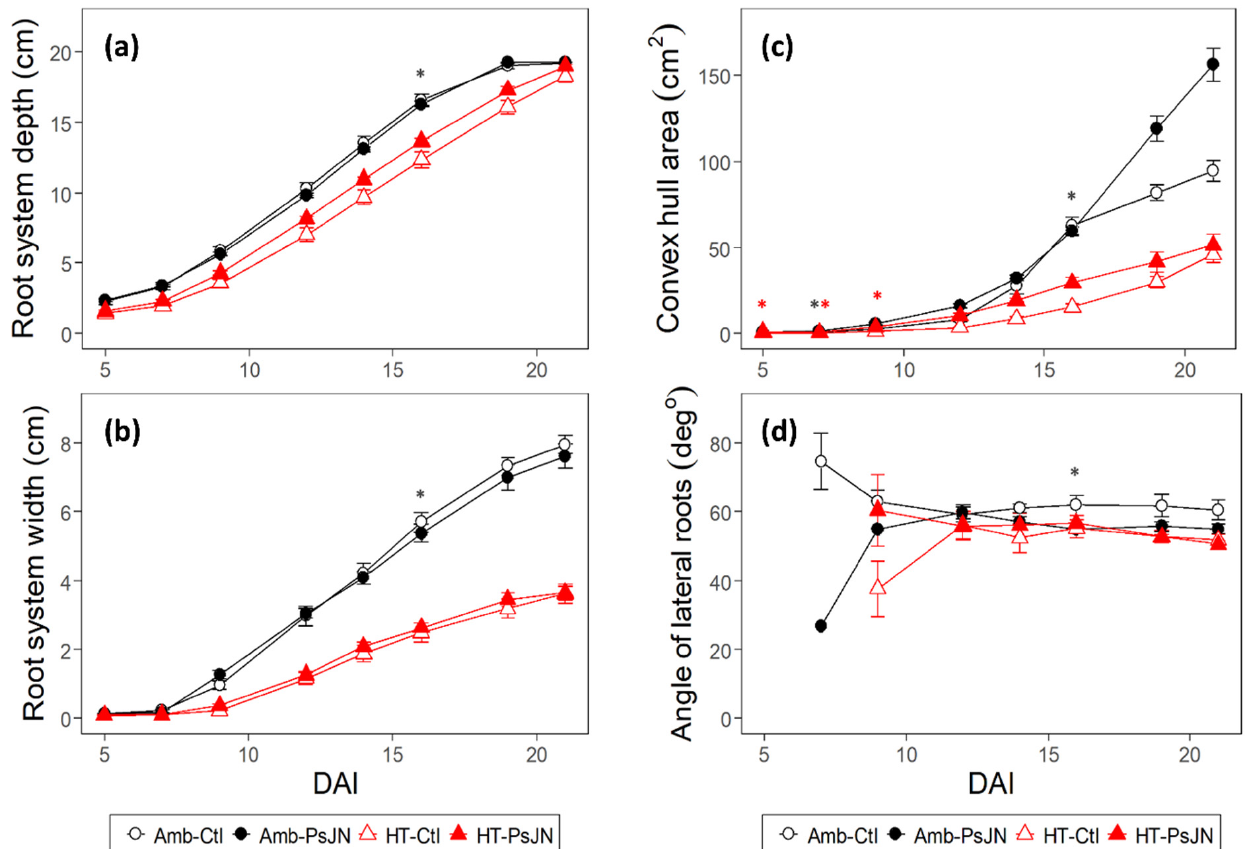
Figure 3. Root system morphological traits. Traits were measured from plants with or without bacteria PsJN inoculation under ambient or high temperature conditions from 5 to 21 days after inoculation (DAI) in the GrowScreen-Agar II platform. ( a ) Root system depth, ( b ) root system width, ( c ) convex hull area, and ( d ) branching angle of 1st-order lateral roots. Temperature—black and circle symbol (ambient temperature), red and triangle symbol (high temperature); Bacterial application—empty symbol (control), filled symbol (PsJN-inoculated). Treatments: Amb-Ctl (control plants under ambient condition), Amb-PsJN (PsJN-inoculated plants under ambient condition), HT-Ctl (control plants under high temperature), and HT-PsJN (PsJN-inoculated plants under high temperature). All of the points are the mean ± standard error of n = 12 (Amb-Ctl), 15 (Amb-PsJN), 12 (HT-Ctl), 8 (HT-PsJN) samples within each treatment. Asterisks “*”: Black—significant difference between mean of PsJN-inoculated and control plants under ambient condition, red—significant difference between mean of PsJN-inoculated and control plants under high temperature condition; these were based on the Student’s t -test with p < 0.05.